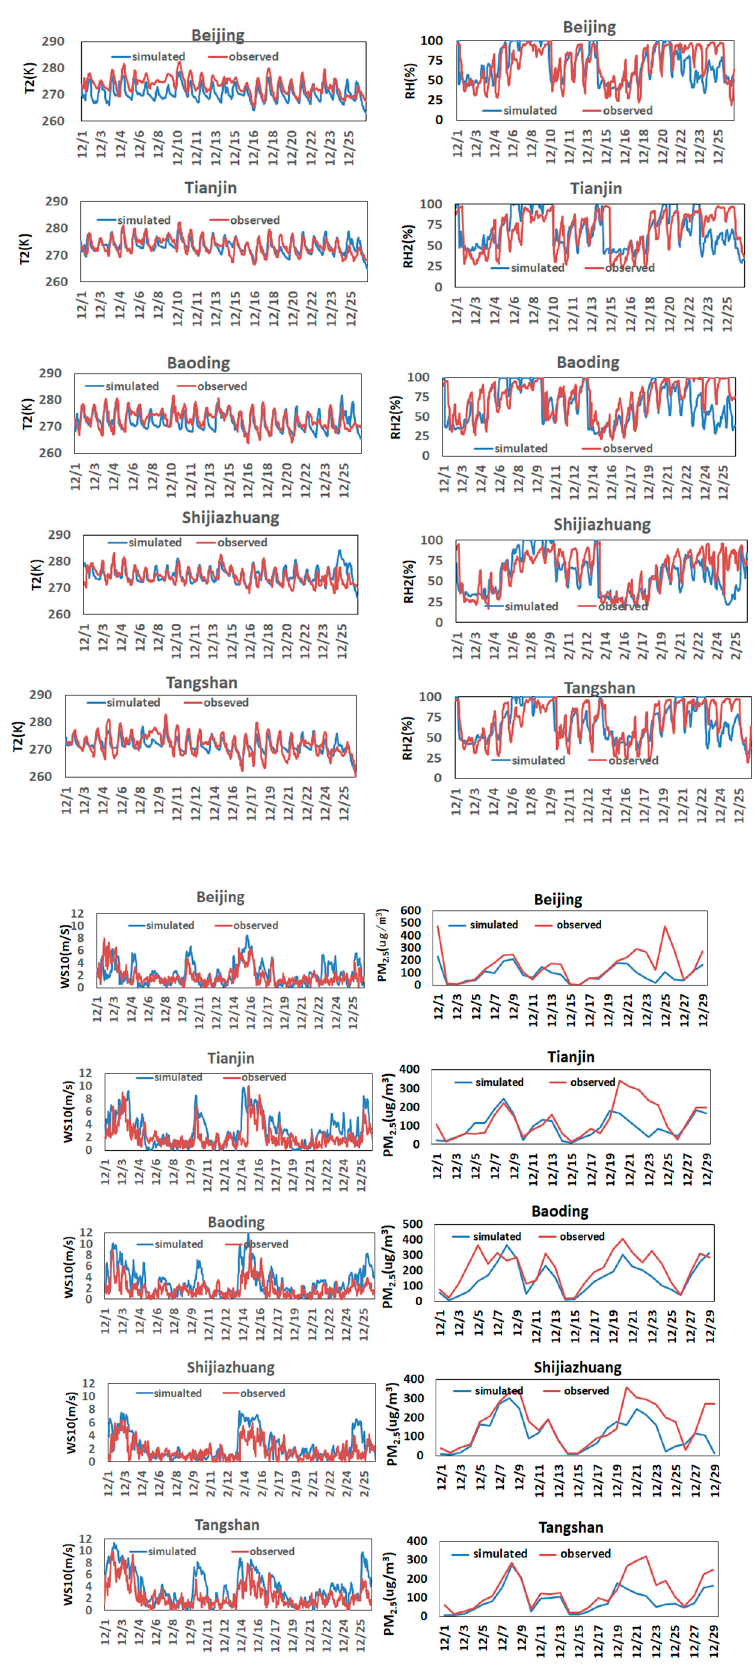
Figure 2. Comparison of temperature at 2 m (T2), relative humidity at 2 m (RH2), wind speed at 10 m (WS10), and PM 2.5 between the simulated and observed results.